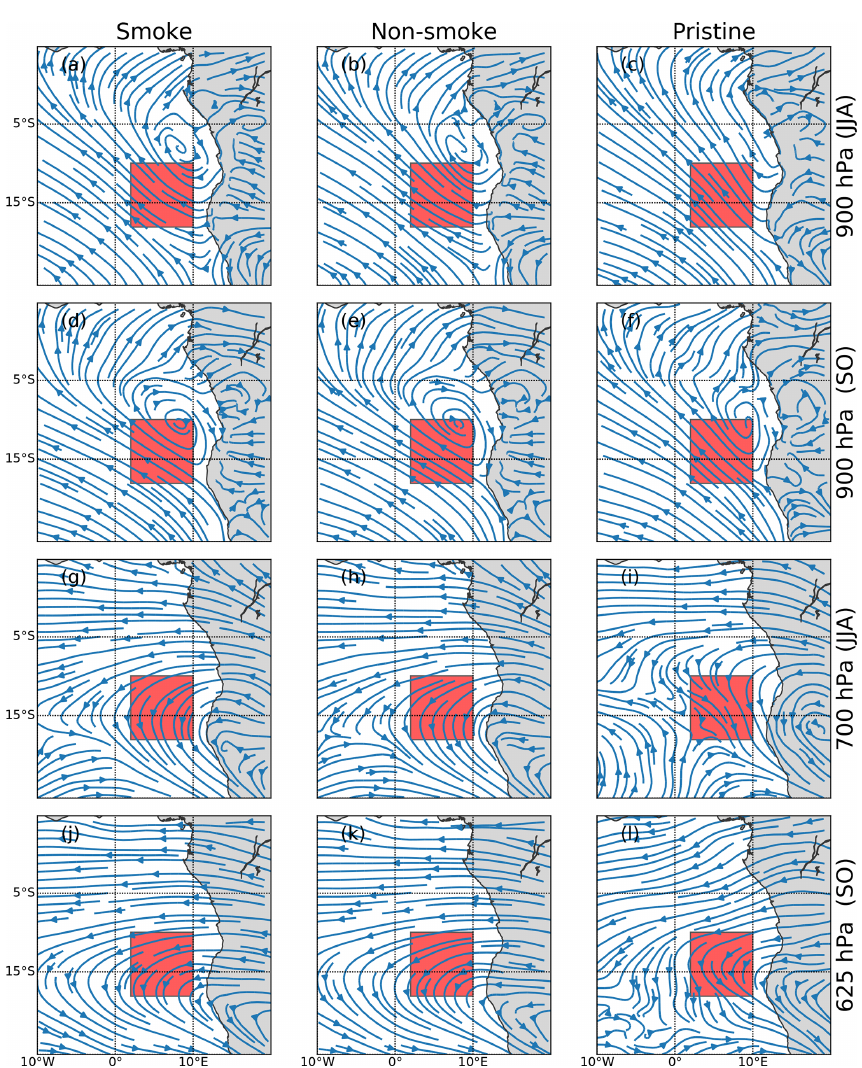
Figure 4. Streamlines corresponding to the average horizontal wind speed at 900hPa (representative cloud level) in JJA and SO and 700 (625)hPa (representative aerosol layer level) in JJA (SO) during the days when the smoke, non-smoke aerosol, and pristine cases were identified during the period 2007–2010. The red square corresponds to the area of study.